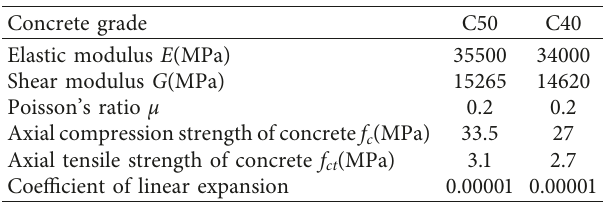
Figure 5: Pier and foundation: (a) cross-section of a pier; (b) longitudinal section; (c) overall plan. Table 1: Mechanical properties of concrete.